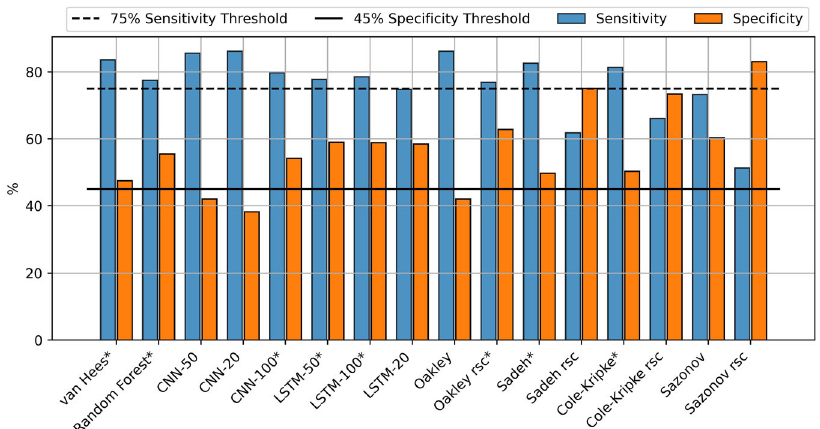
Fig. 1 Sensitivity and speci fi city for each algorithm predicting sleep or wake compared to PSG. Sensitivity values are shown in blue and speci fi c values are shown in orange. Algorithms that met the sensitivity and speci fi city thresholds are indicated with an asterisk.